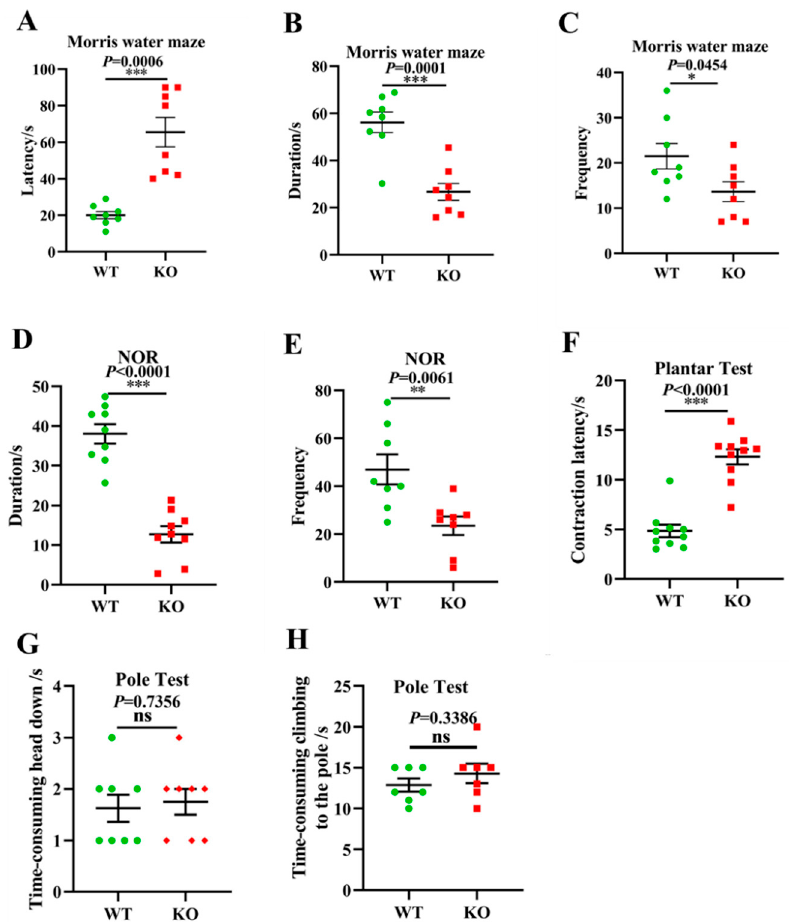
Figure 6. Atp11b -KO mice exhibit aging behavior. ( A ) The Morris water maze test showing the latency of mice. ( B ) The Morris water maze test showing the time that mice spent in the target quadrant. ( C ) The Morris water maze test showing the frequency that mice entered the target quadrant. ( D ) The NOR test demonstrating the time that mice spent exploring a novel object. ( E ) The NOR test demonstrating the frequency that mice explored a novel object. ( F ) Plantar test showing the contraction latency of mice. ( G ) The first time-consuming head down of mice in the pole test. ( H ) The time-consuming climbing up the pole of mice in the pole test. For each group of mice, n = 8–10. The mice were 12 months old. Data are expressed as the mean ± SEM. Student’s t -test, * p < 0.05, ** p < 0.01, *** p <